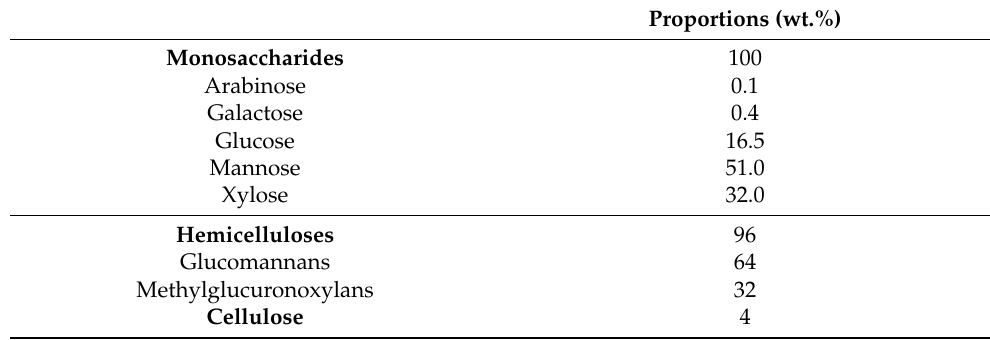
Table 3. Mono- and polysaccharide proportions in the hemicelluloses extracted from a sulfite pulp by HPAEC-PAD.